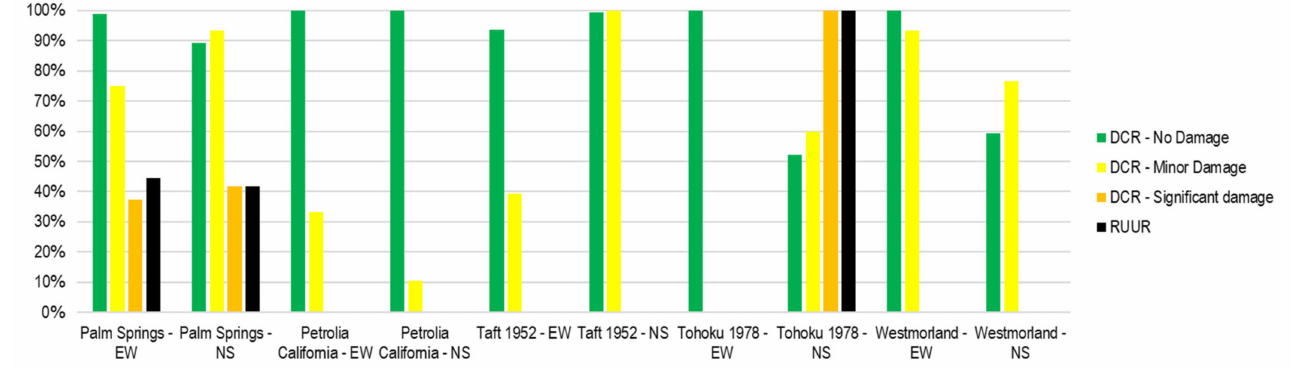
Figure 24. DCR and RUUR for story drift ratio of the validation process.